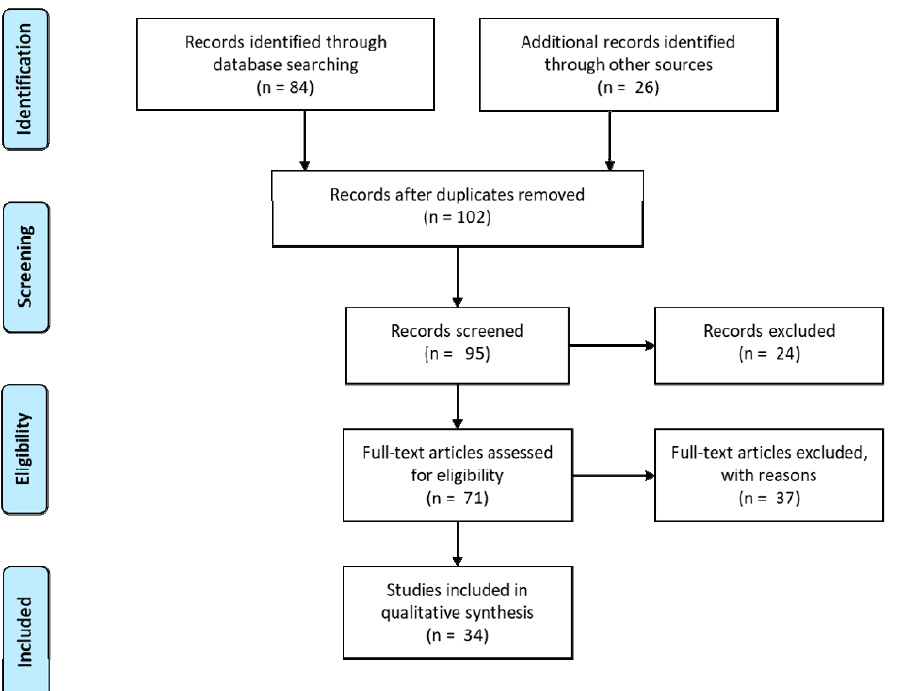
Figure 1. Flow diagram of the search results of the first topic following the Preferred Reporting Items for Systematic Reviews and Meta-Analyses (PRISMA) protocol [82].